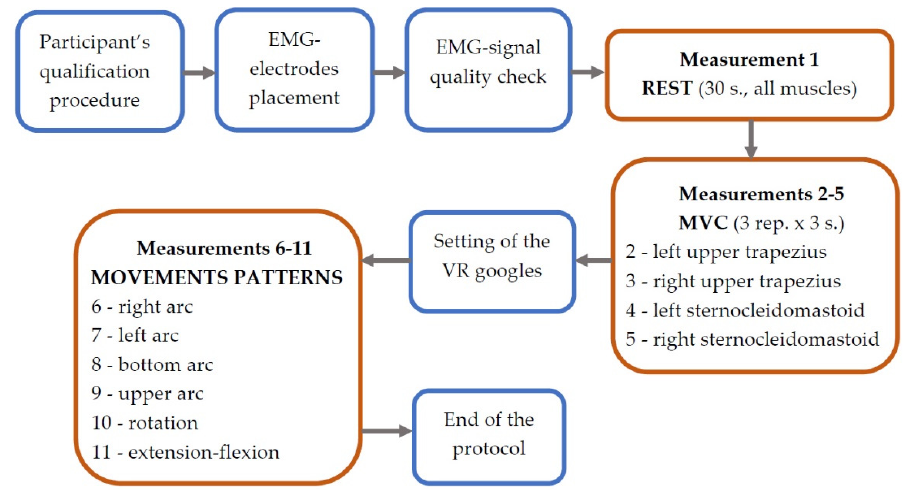
Figure 3. Study protocol.